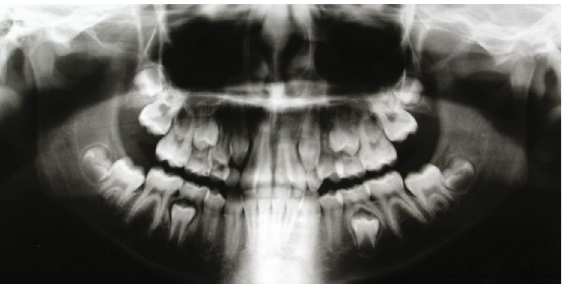
Figure 4: Initial panoramic radiograph. Table 1: Cephalometric values at the start of treatment.